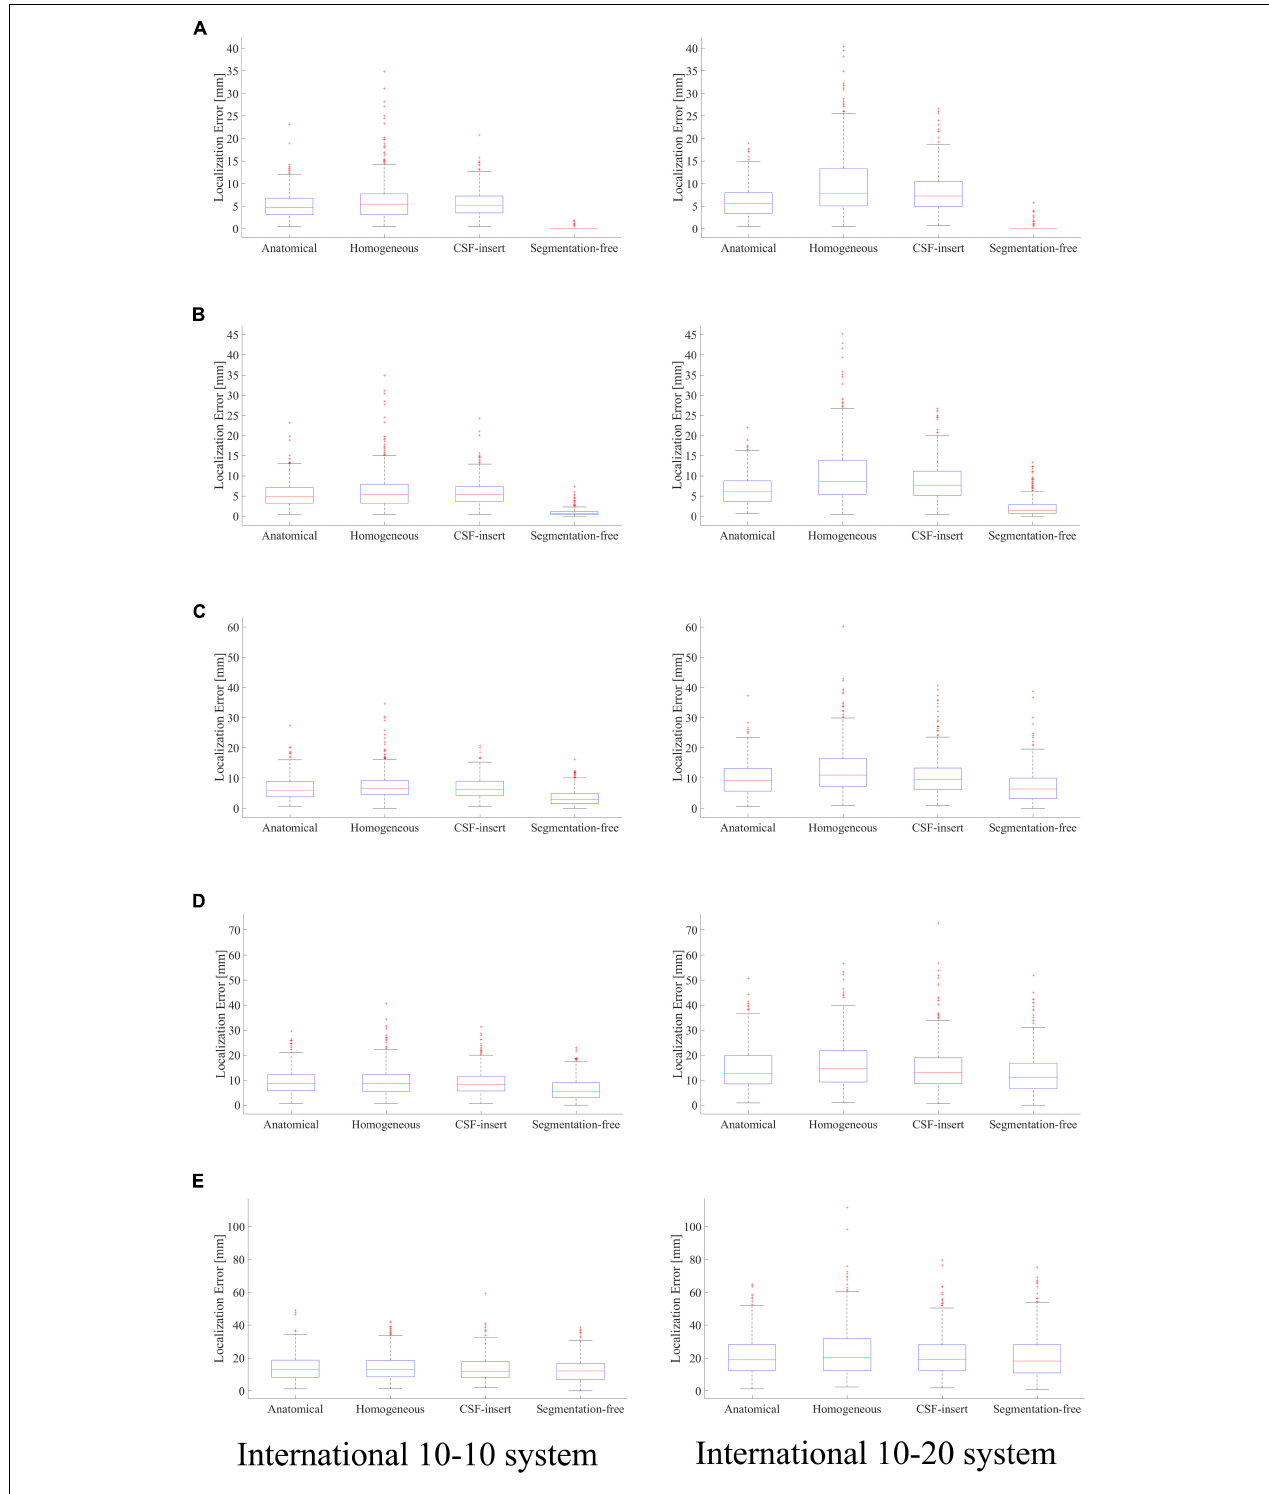
FIGURE 7 | Localization error in different head models with SNR of, (A) ∞ dB, (B) 20 dB, (C) 10 dB, (D) 5 dB, and (E) 0 dB. Boxplots are calculated from 500 patterns of selected wave sources. In the inverse problem, measured potentials are fixed at the value calculated in the segmentation-free model. LFM is calculated in each